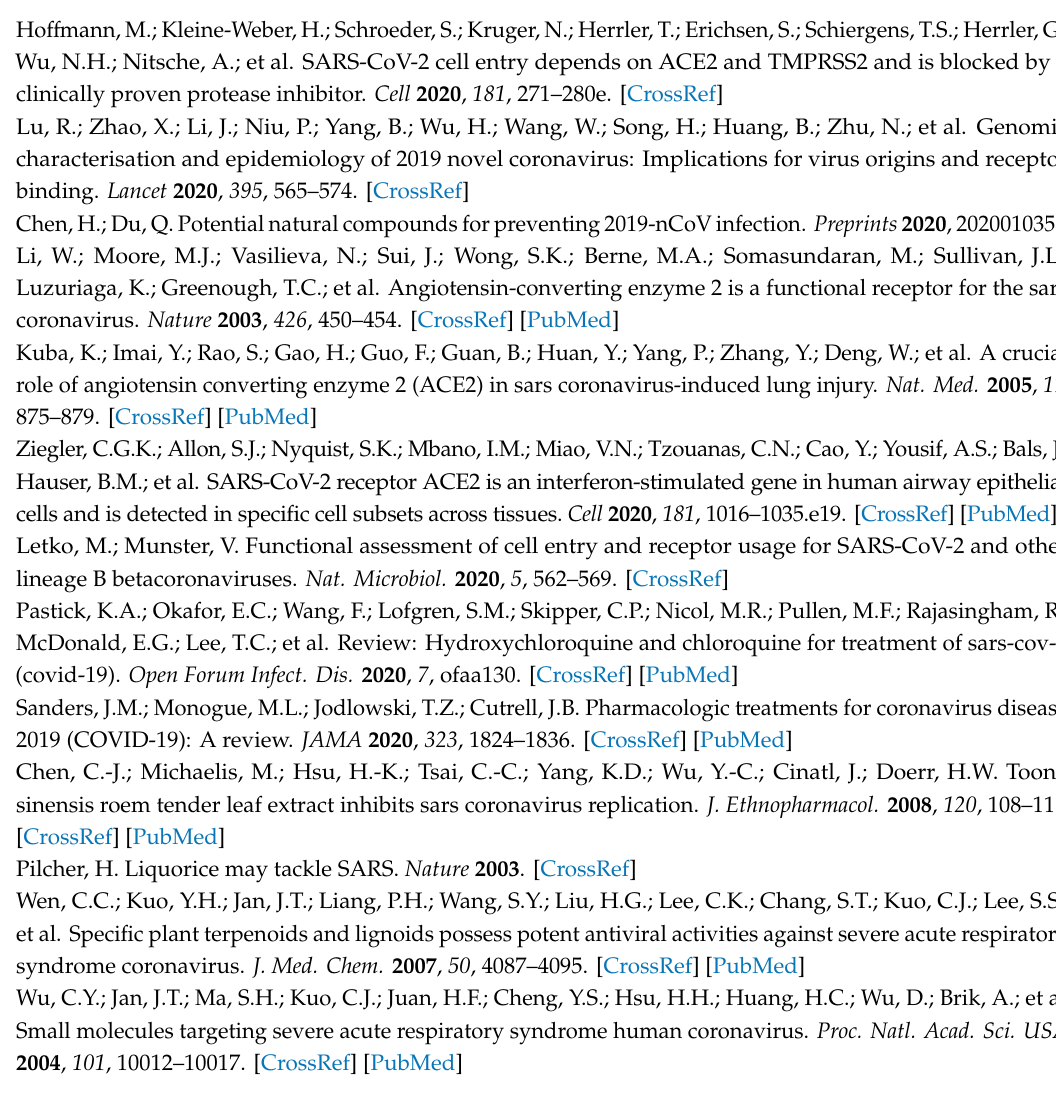
Figure S1: Cytotoxic e ff ect of essential oils on HT-29 cells. Figure S2: Cytotoxic e ff ect of major compounds of geranium and lemon essential oils. Table S1. Main components and their relative contents (%) of Bergamot oil derived from citrus rind (peel) of Citrus bergamia . Table S2. Main components and their relative contents (%) of cypress oil derived from needles of Cupressus sempervirens. Table S3. Main components and their relative contents (%) of Eucalyptus oil derived from leaves of Eucalyptus globulus. Table S4. Main components and their relative contents (%) of juniper berry oil derived from berries of Juniperus communis . Table S5. Main components and their relative contents (%) of neroli oil derived from flowers of Citrus aurantium. Table S6. Main components and their relative contents (%) of petitgrain oil derived from leaves and twigs of Citrus aurantium . Table S7. Main components and their relative contents (%) of tangerine oil derived from fruit peel of Citrus reticulata. Table S8. Main components and their relative contents (%) of tea tree oil derived from leaves of Mellaleuca alternifolia